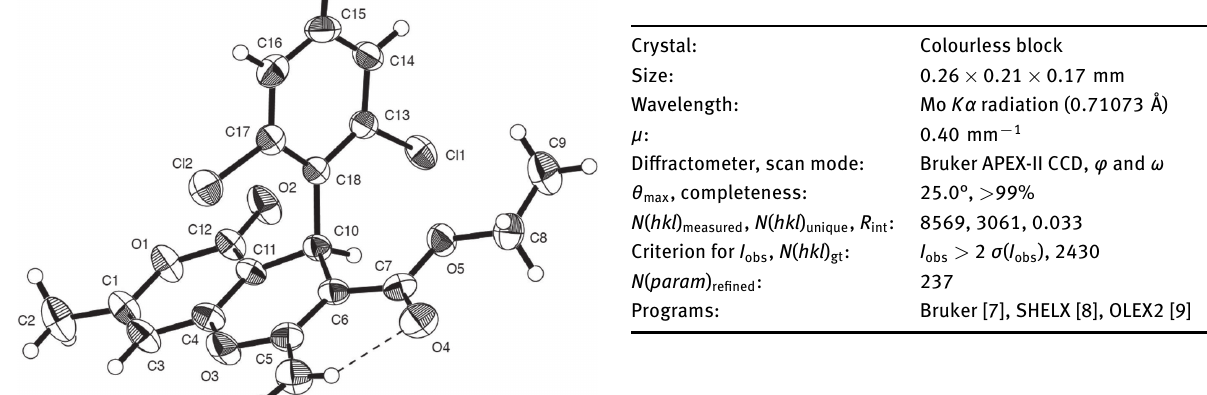
Table 1: Data collection and handling.